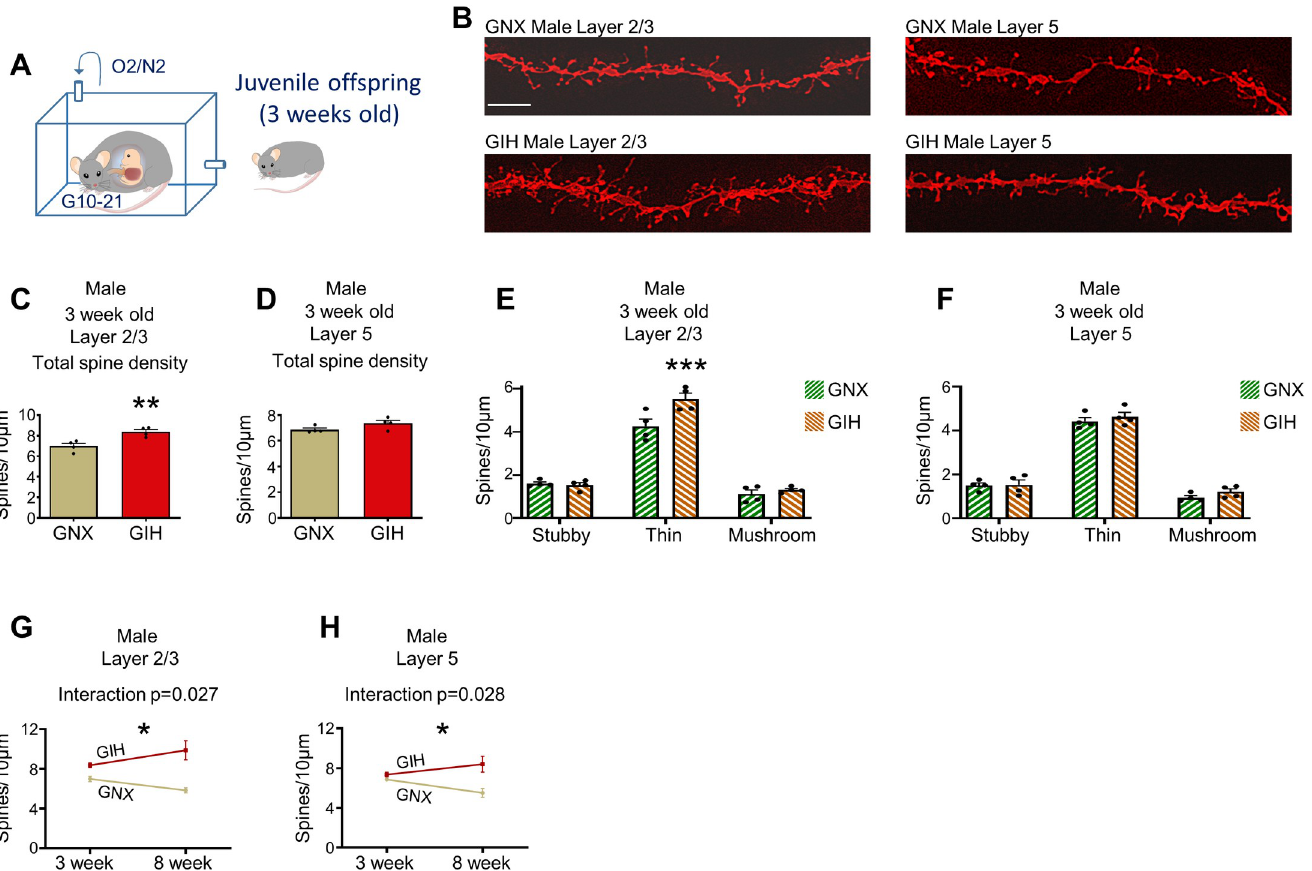
Fig 6. mPFC pyramidal neuronal dendritic spine density and morphology in layer 2/3 and layer 5 in 3-week-old male GIH offspring. (A) Schematic depicting GNX and GIH offspring age pertaining to all data in Fig 6. (B) Representative layer 2/3 and layer 5 pyramidal neuron dendrite segments from 3-week-old male GNX and GIH offspring. Scale bar = 10 μ m. (C) Assessment of total layer 2/3 dendritic spine density revealed a significant increase in male GIH offspring relative to male GNX offspring [t (df,6) = 3.888, p = 0.0081]. n = 4 GNX and 4 GIH rats. (D) Assessment of total layer 5 dendritic spine density revealed no differences in male GIH offspring relative to male GNX offspring [t (df,6) = 1.884, p = 0.1086]. n = 4 GNX and 4 GIH rats. (E) Spine subtype density analysis revealed a significant increase in layer 2/3 thin spine density in male GIH offspring [Bonferroni post hoc (df,18) p = 0.0009] and no alteration in the density of stubby [Bonferonni post hoc (df,18) p = 1.0] or mushroom spines [Bonferroni post hoc (df,18) p = 1.0]. n = 4 GNX and 4 GIH rats. (F ) No differences in the density of any layer 5 spine subtypes were identified between male GIH and GNX offspring [Bonferroni post hoc (df,18) stubby p = 1.0; thin p = 1.0; mushroom p = 0.7706]. n = 4 GNX and 4 GIH rats. (G) A significant interaction was detected between layer 2/3 total spine density in GIH versus GNX offspring as a function of age [2-way ANOVA F(1,12) = 6.366, p = 0.0268]. (H ) A significant interaction was detected between layer 5 total spine density in GIH versus GNX offspring as a function of age [2-way ANOVA F(1,12) = 6.293, p = 0.0275]. All bar graphs are the mean + SEM. The data underlying this figure can be found in S1 Raw Data. GIH, gestational intermittent hypoxia; GNX, gestational normoxia; mPFC, medial prefrontal